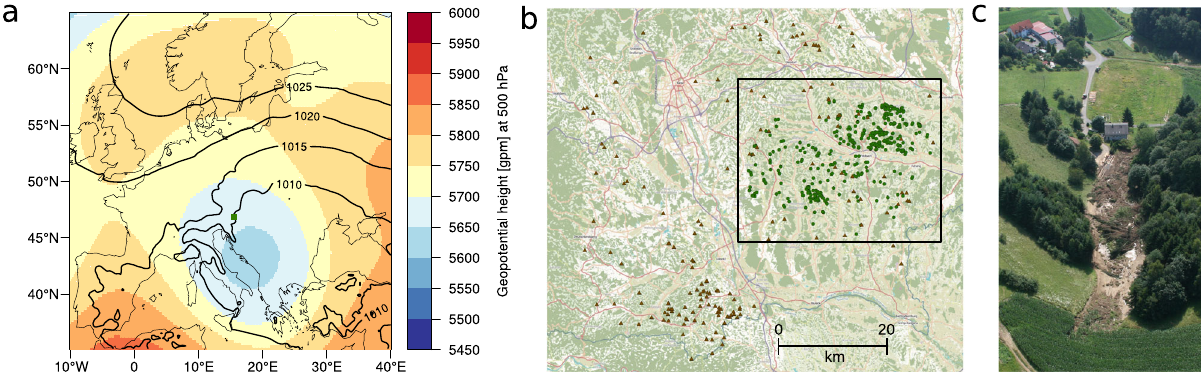
Fig. 1 Meteorological and landslide event of 2009. a Mean large-scale circulation during 22 – 26 June 2009 over Europe derived from IFS operational analysis. Sea level pressure (contours, hPa) and geopotential height at 500 hPa (shading, gpm). b Map (region marked as green rectangle in a ) of actual landslides recorded during the 2009 event (green; 2014 landslides additionally used to calibrate the landslide model are marked in brown. See Methods for detail). The target region (roughly coinciding with the Feldbach district and referred to as Feldbach region in the following) considered for the landslide assessment is shown as black rectangle (Supplementary Fig. 1). Map © OpenStreetMap contributors. c Aerial view of a landslide occurring during the event. Credit: State of